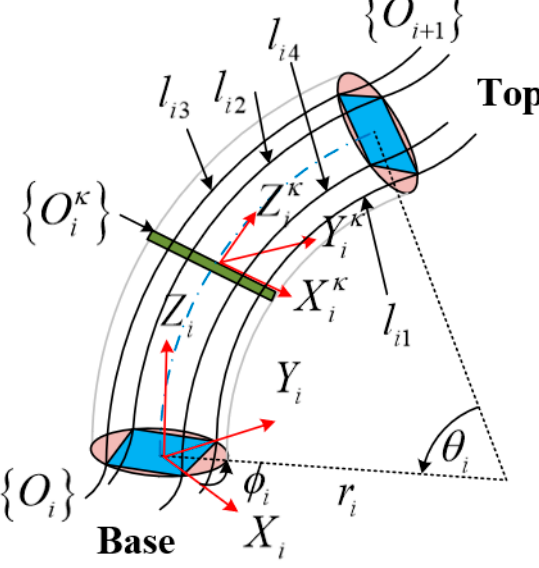
Figure 2. Deformation mode of a single continuum node.